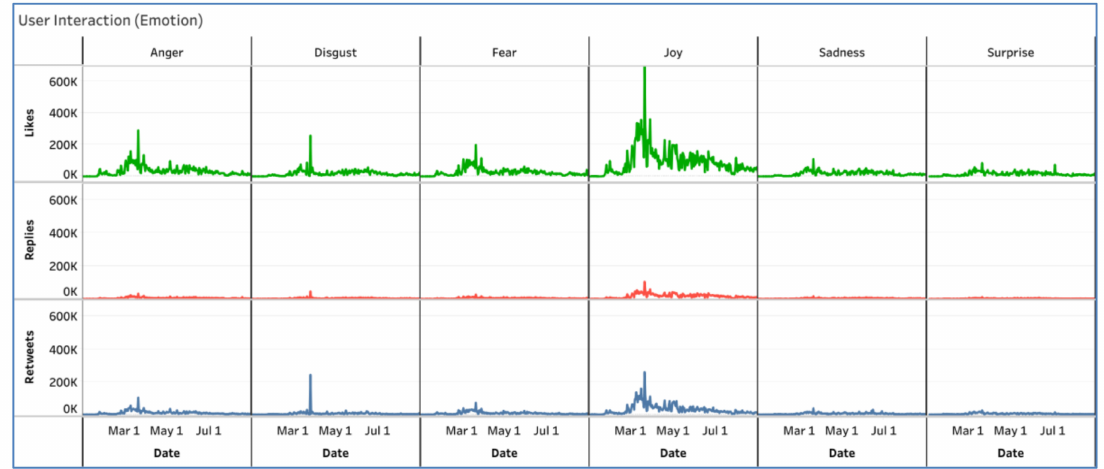
Figure 10. User Interaction (Emotions).